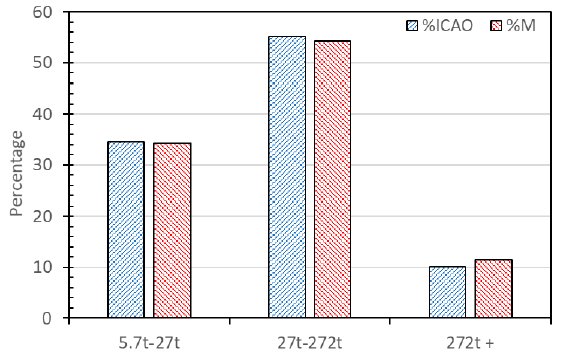
Figure 6. Distribution of aircraft mass category for accidents with maintenance contributions.